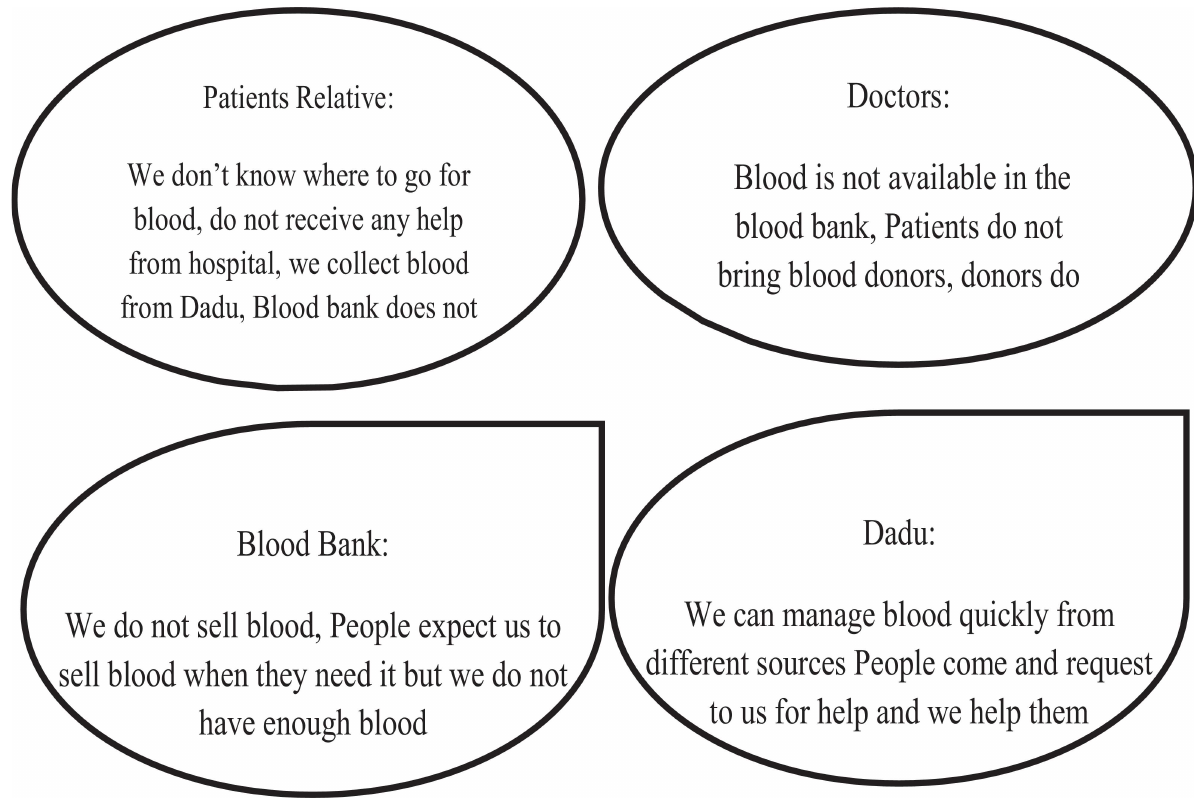
Fig 2. Different voices from different